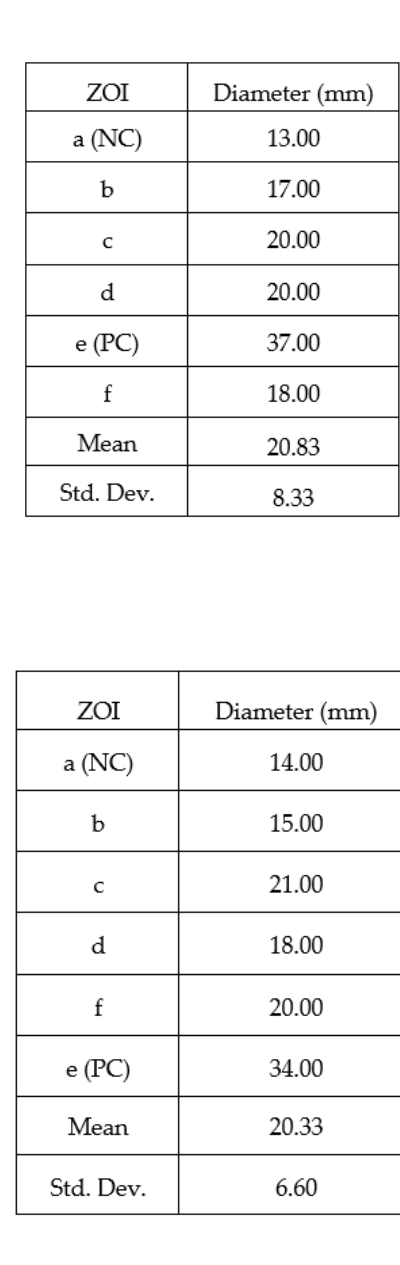
Figure 8. Antibacterial activity. ( A ) Escherichia coli MTCC40 pEx2717—( a ) Negative control (NC)— D.I. water ( b ) 10 µg/mL, ( c ) 25 µg/mL, ( d ) 50 µg/mL, ( e ) Positive control (PC)—Ciprofloxacin 10 µg/mL, ( f ) 75 µg/mL and ( B ) Staphylococcus aureus MTCC 87 Mkv2011 ( a ) Negative control (NC)— D.I. water ( b ) 10 µg/mL ( c ) 25 µg/mL ( d ) 50 µg/mL ( e ) Positive control (PC)—Ciprofloxacin 10 µg/mL, ( f ) 75 µg/mL. AC-AgNPs pose a greater volume surface-to-volume ratio related to their bulk equiv-